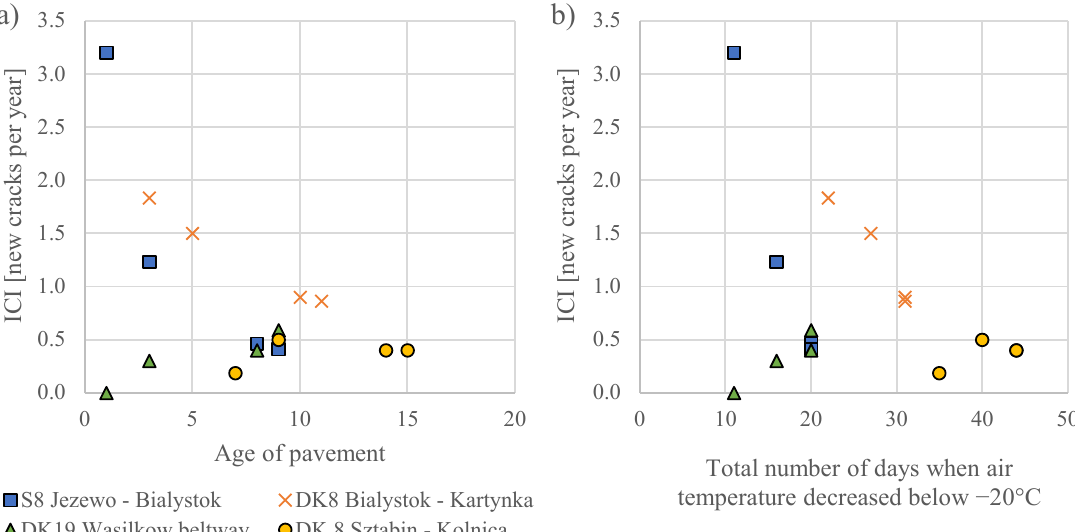
Figure 6. The annual average increase in cracking index in relation to ( a ) pavement age and ( b ) total number of days when air temperature decreased below −20 °C.